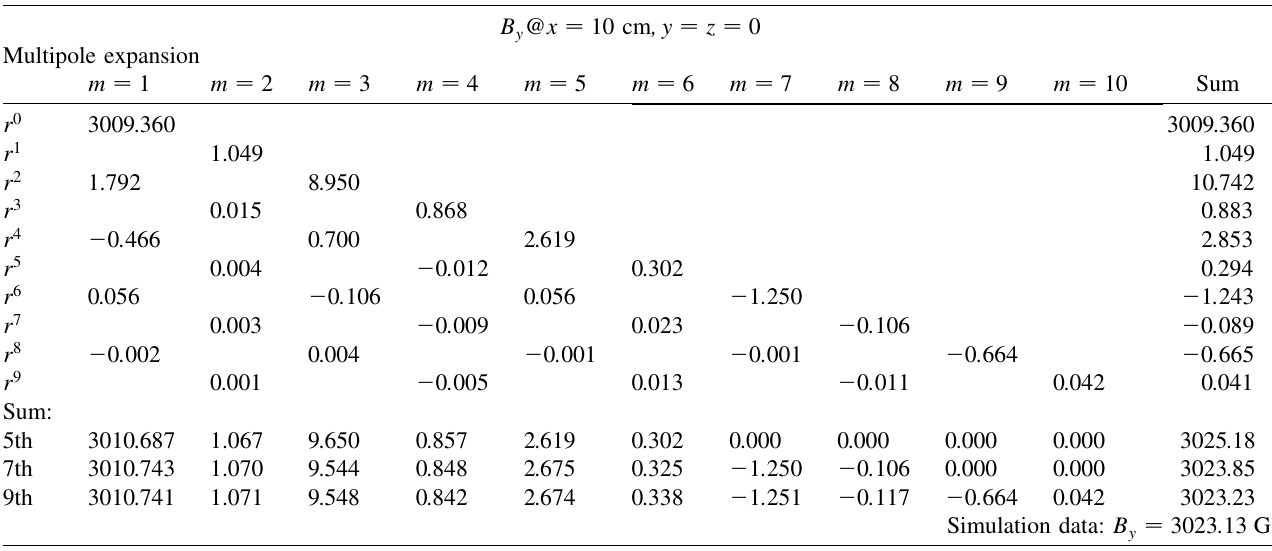
@ x (cid:2) 10 cm , y (cid:2) z (cid:2) 0 y